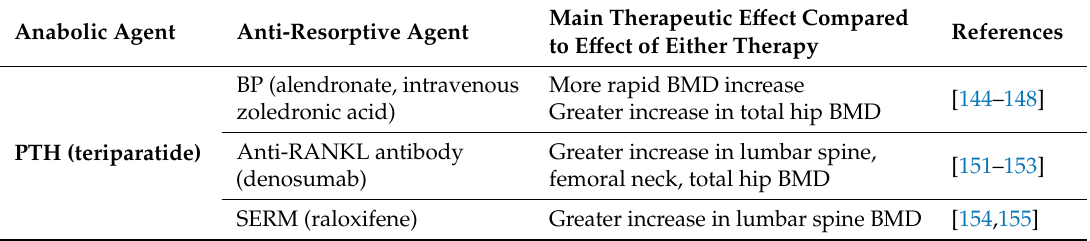
Table 2. Summary of combination therapy with anabolic and anti-resorptive